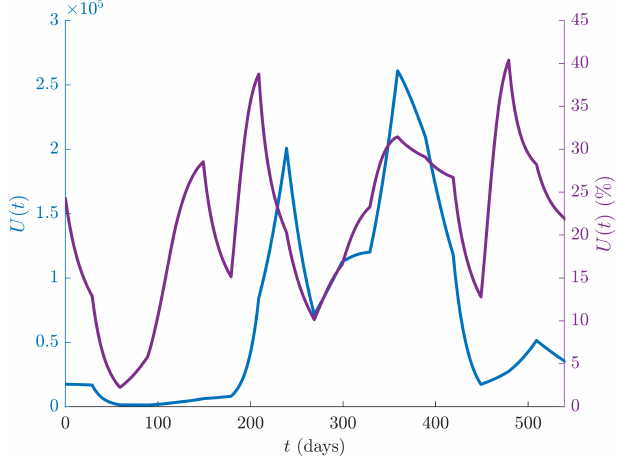
Figure 4. IGM simulation of U (blue line, left ordinate axis) and its percentage with respect to the total number of infected individuals U + I (violet line, right ordinate axis).